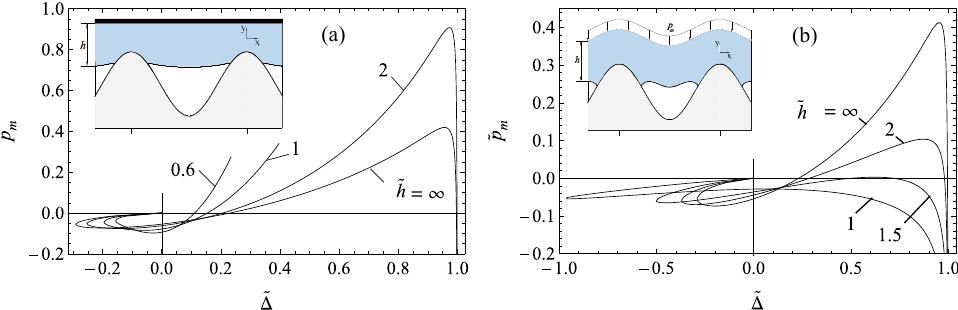
ν 2 1 p / ( Eq 0 Λ ) vs. the dimensionless mean − (cid:0) (cid:1) ν 2 1 q 0 ∆ γ / ( π E ) = 0.05, and − (cid:0) (cid:1)